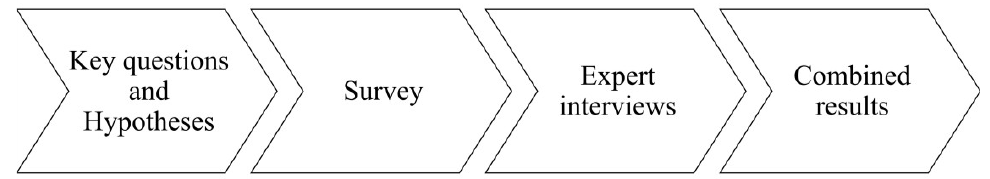
Figure 4. Process of empirical studies.